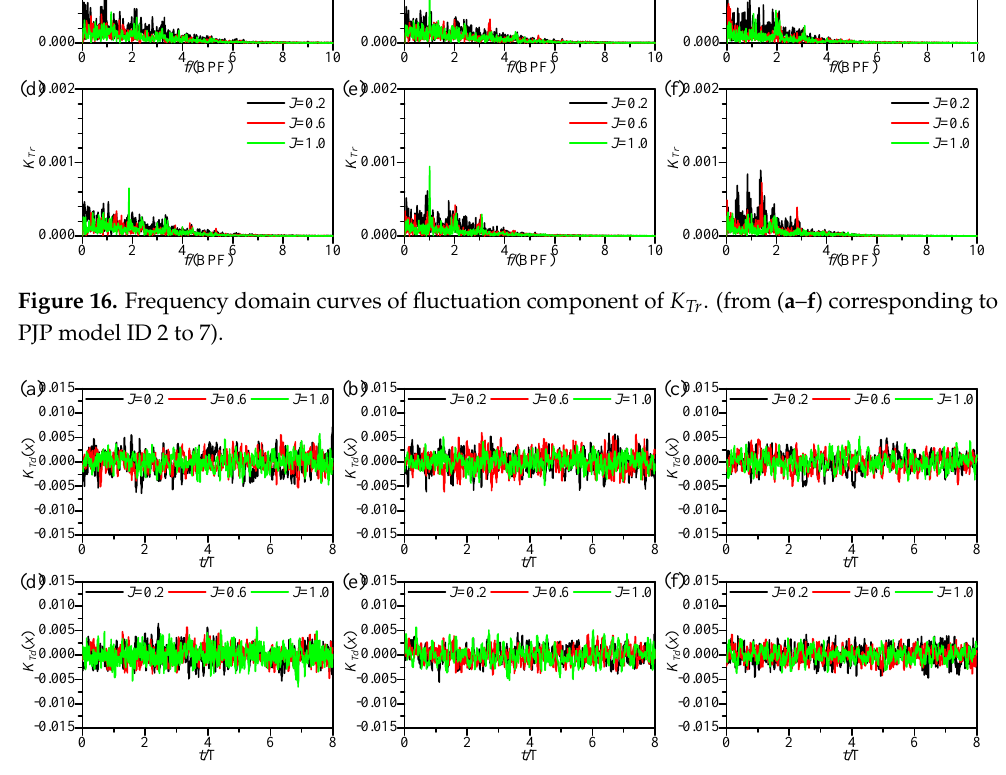
Figure 17. Time domain curves of fluctuation component of K Td ( x ) . (from ( a – f ) corresponding to PJP model ID 2 to